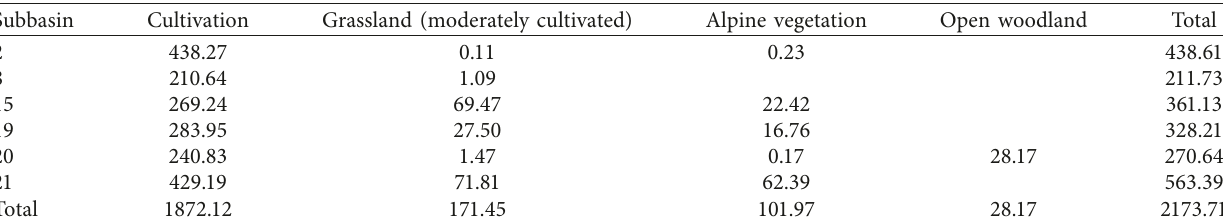
Table 9: Sediment yield and land use.